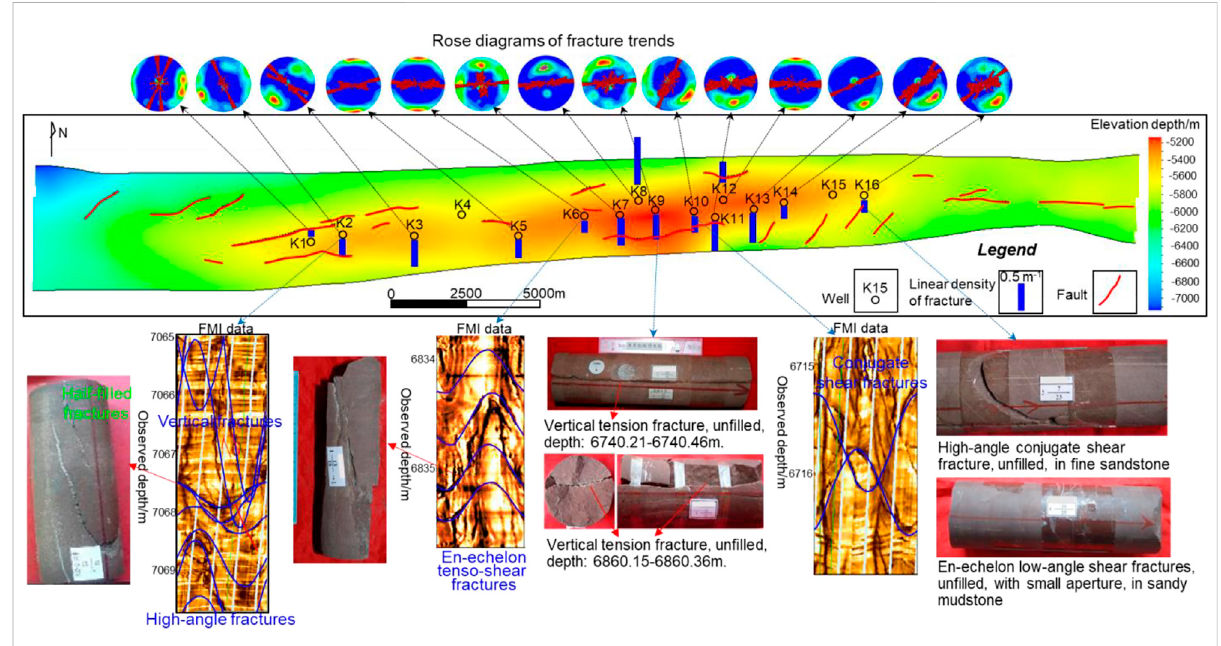
FIGURE 2 Characteristics of structural fractures observed in drill cores and FMI of Kehsen